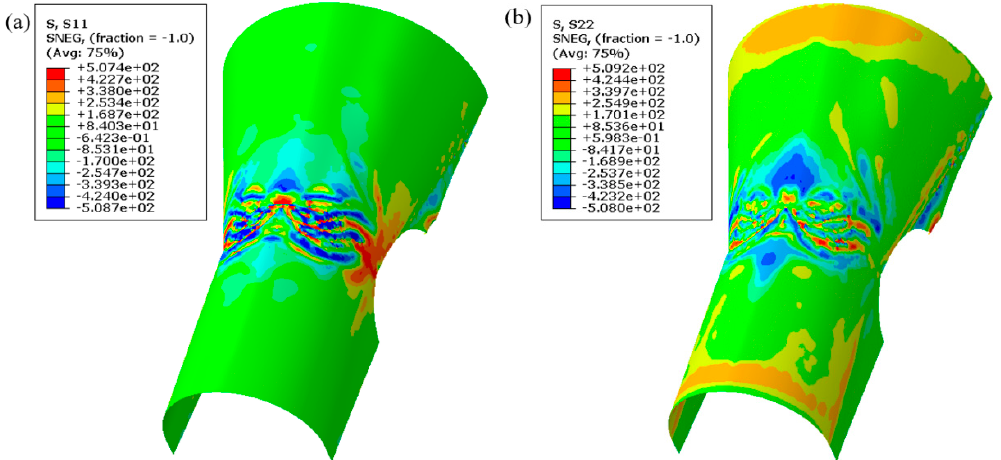
Figure 9. Stress distribution under initial blank F: ( a ) Axial stress; ( b ) hoop stress.